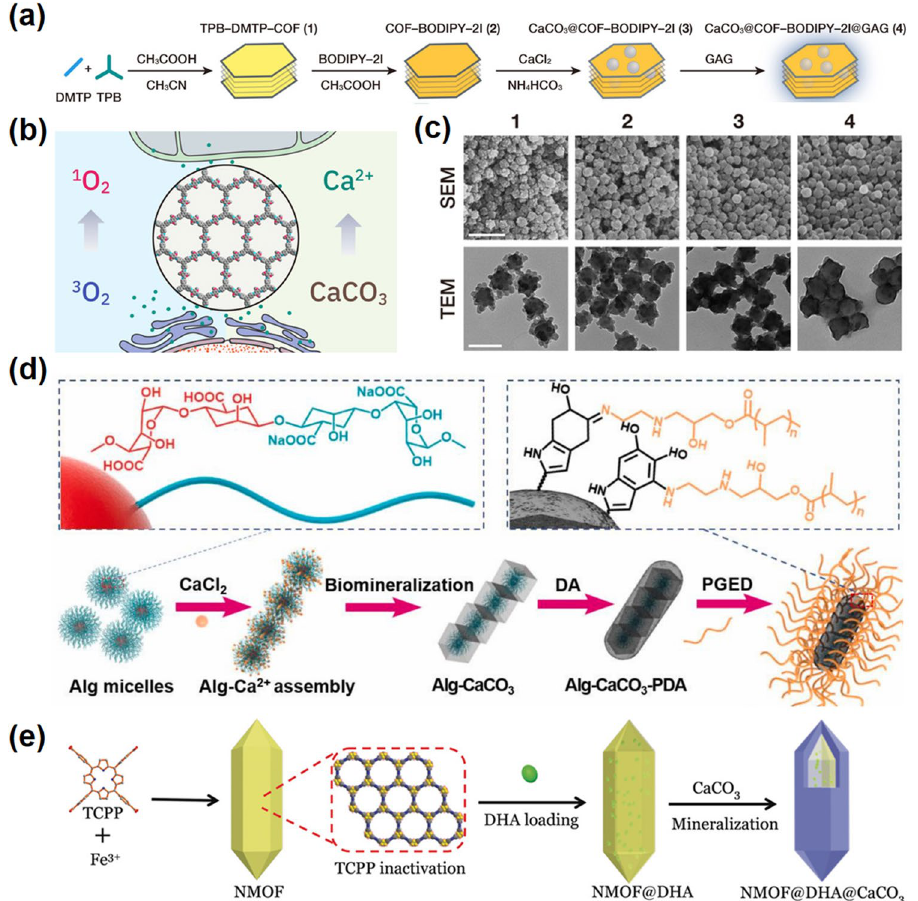
Fig. 2 Calcium carbonate-based nanomaterials. a Preparation process of CaCO 3 @COF-BODIPY-2I@GAG NMs. b Schematic illustration of synergistic induction of intracellular calcium overload by. 1 O 2 and exogenous calcium delivery. c SEM and TEM images of